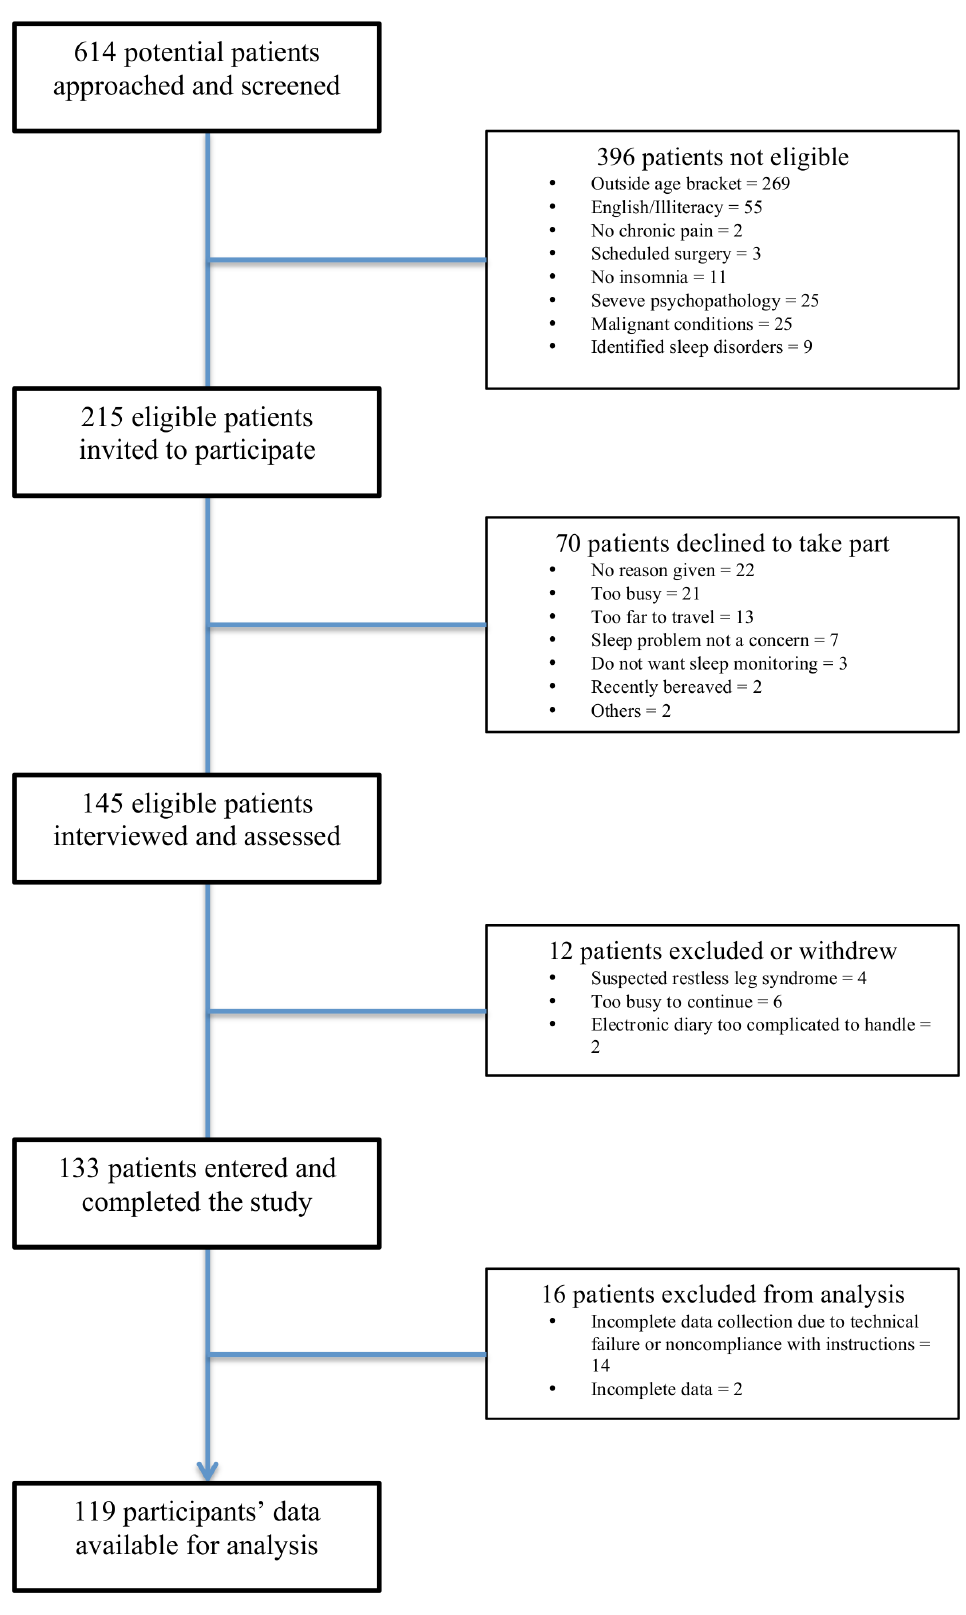
Figure 2. Participant recruitment flowchart.